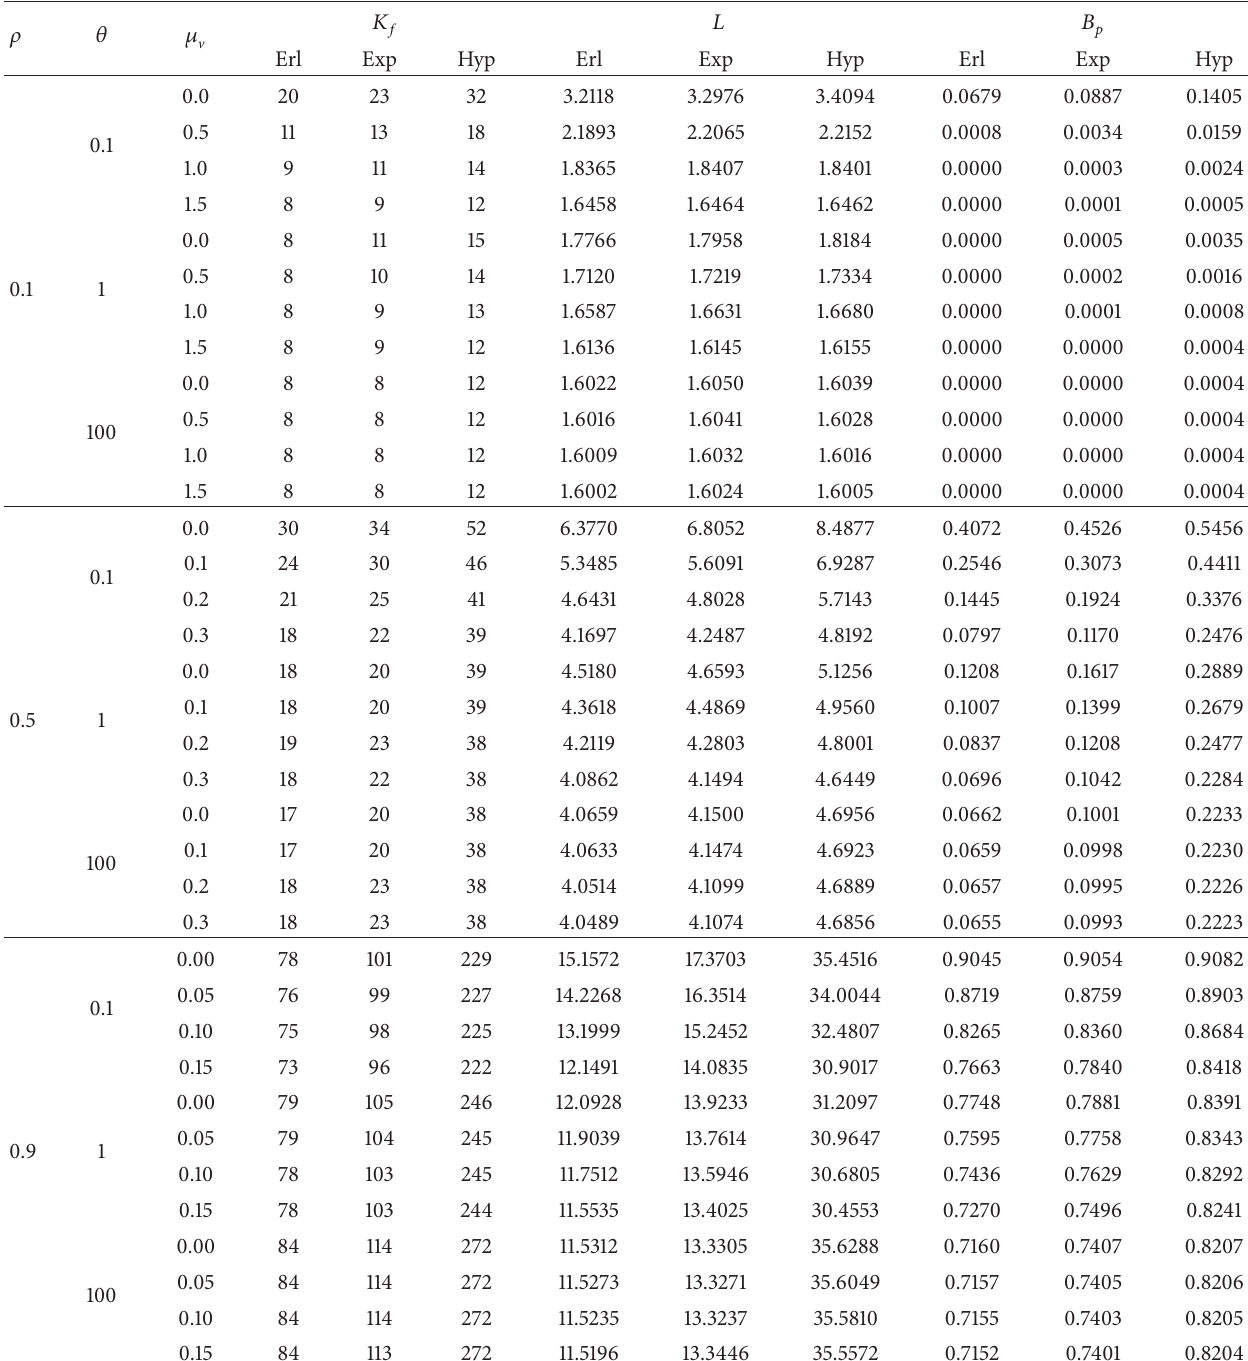
Table 3: Multiserver model with 𝑐 = 6